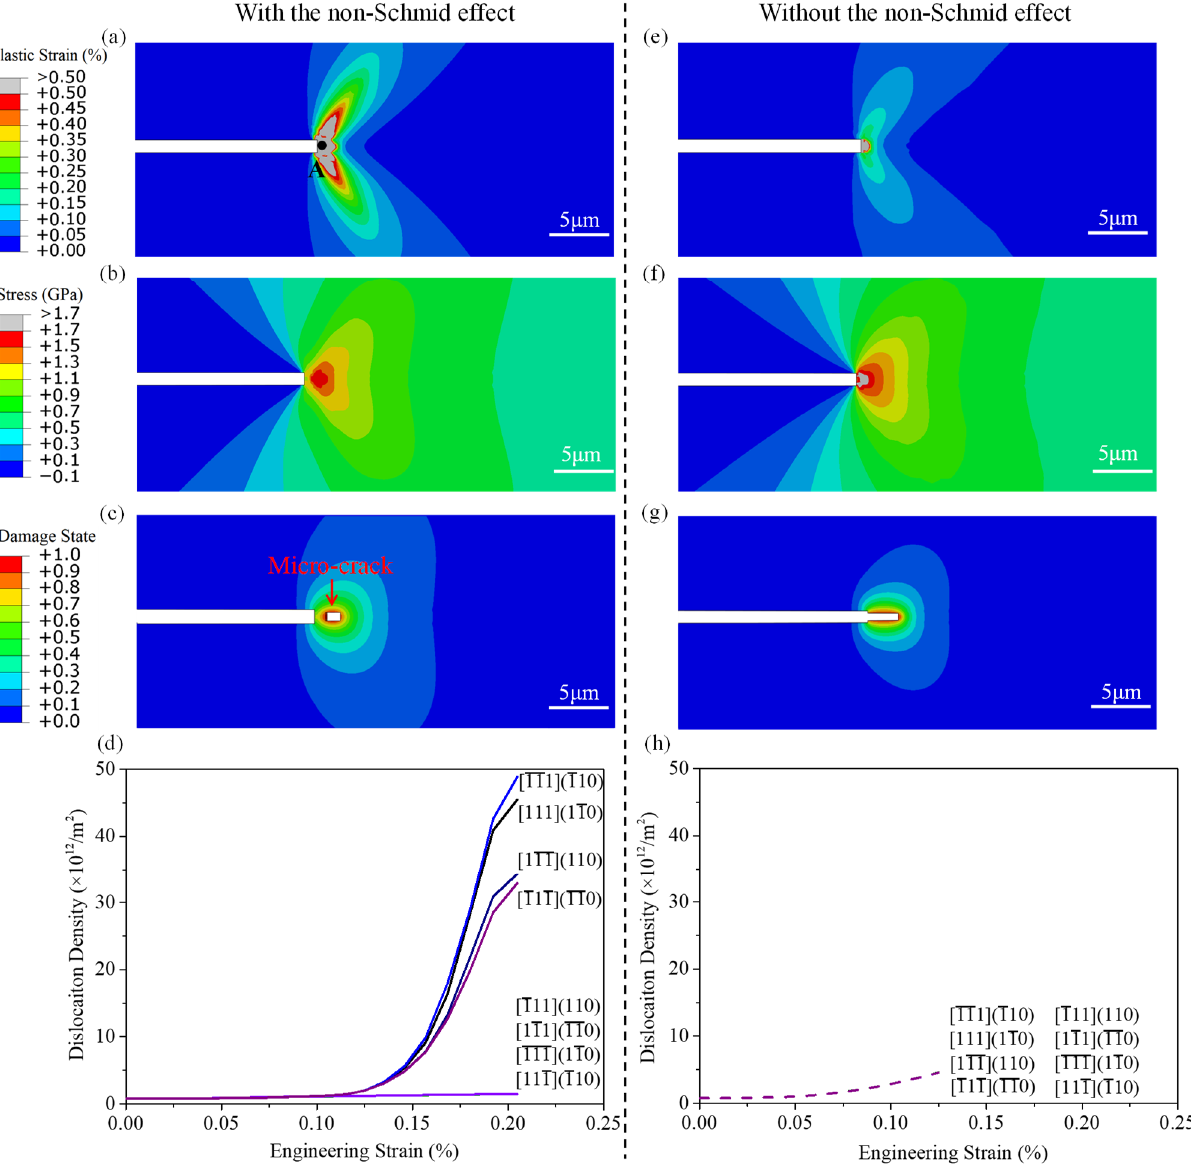
Figure 5. Distribution of equivalent plastic strain, normal tensile stress and damage state, and evolution of the dislocation density for the semi-brittle fracture of tungsten at 295 K. ( a – d ) considers the NS effect, while ( e – h ) neglects this effect. ( a , e ) are the distribution of equivalent plastic strain, while ( b , f ) are the distribution of normal tensile stress, when the engineering strain is 0.15%. ( c , g ) are the damage distribution during the crack initiation. ( d , h ) are the dislocation density evolution for a given position (marked with “A”) near the crack tip before the material is totally damaged (or the element is